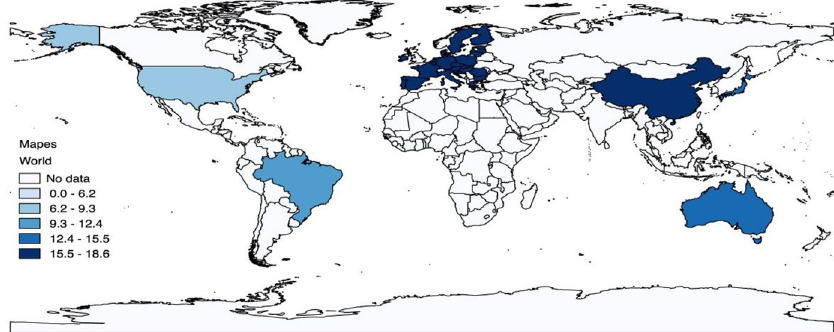
Fig. 2 Labour income attributed to direct exports in relation to total labour income (%), 2014. Source: Author’s calculations based on the